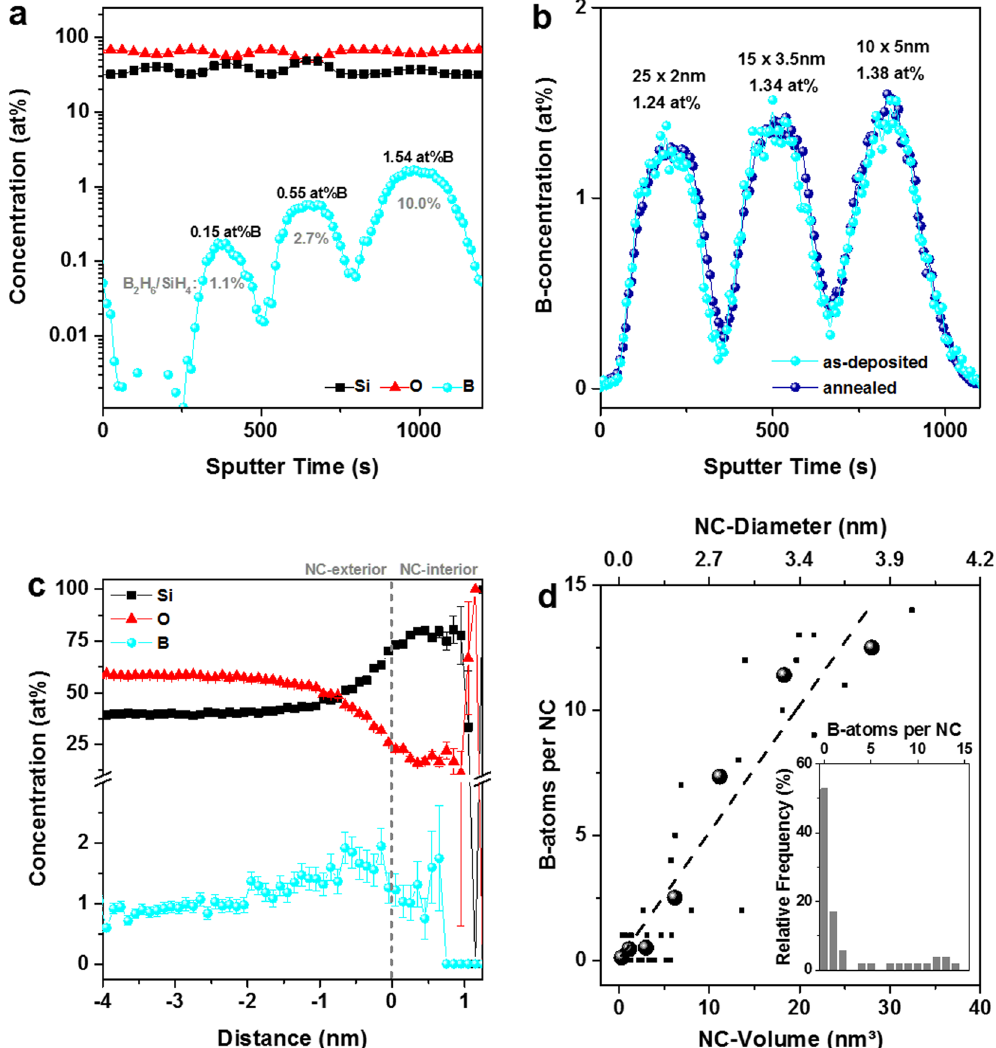
Figure 1. Analyses of B-concentration and B-incorporation. ( a ) Quantitative composition from MCs + - SIMS measurements of 4 SRO:B films (each ~50 nm) with different B 2 H 6 gas flows, separated by SiO 2 spacer layers. The B 2 H 6 /SiH 4 gas flow ratio as well as the effective B-concentrations are given in numbers. ( b ) B-concentration of nominally identical ~50 nm SRO:B films with maximum B 2 H 6 flux, which were deposited by consecutive ultra-thin films to demonstrate the small influence (approx. − 14% relative) of transient deposition effects. In order to account for this effect, we redefine the nominal B-concentrations listed in ( a ) to: [B min ] = 0.13 at%, [B med ] = 0.47 at%, and [B max ] = 1.32 at%. The other curve (dark blue) shows the same sample after 1100 °C-annealing. ( c ) Proxigram from the APT-measurement of a Si NC superlattice sample with 4.5 nm SRO:B max . The local B-concentration increases slightly from the faraway- matrix towards the NC-interface (negative distances). Inside of the NCs a significant B-concentration is detected in the near-surface region before it drops to zero towards the core of the NCs (positive distances). ( d ) Distribution of the number of B-atoms over the NC-size (small data points: APT raw data; large data points: averaged values from grouping the NCs into volume classes; dashed line: linear fit). The inset shows the relative frequency of NCs with n B-atoms in their volume. Most notably, more than 50% of all NCs are B-free despite 1.32 at% B in the